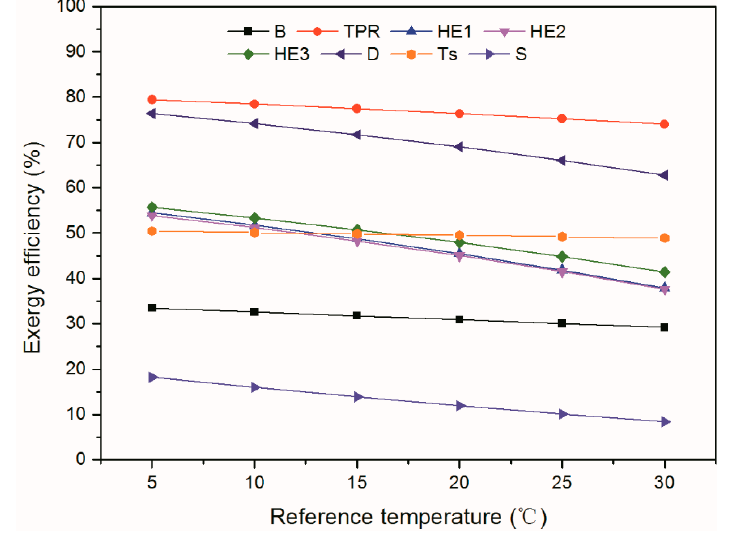
Figure 10. Effect of reference temperature on exergy efficiency of major components.